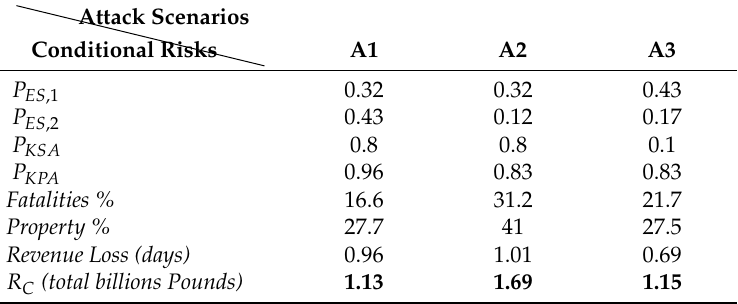
Table 6. Conditional risk for every attack profile (US Dollar equals 0.72 British Pound).